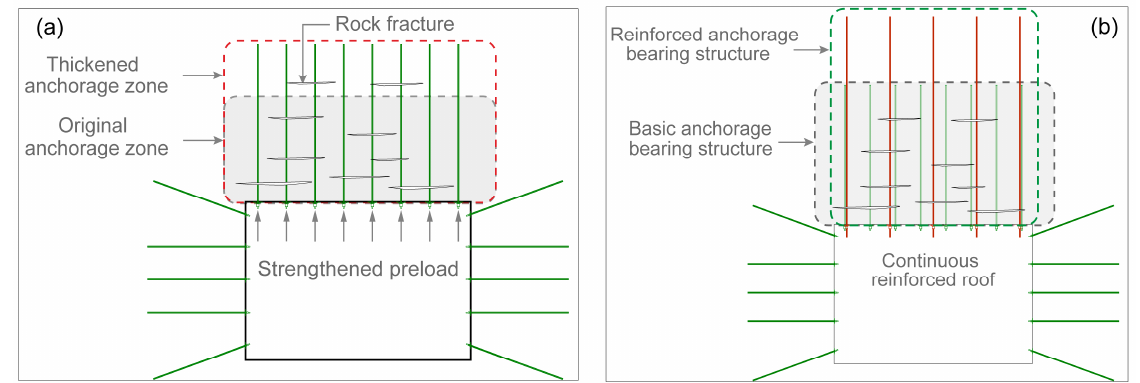
Figure 14. Roof support structure: ( a ) the bearing structure of surrounding rock foundation is strengthened by long bolt and ( b ) the bearing structure of foundation is continuously strengthened by short cable.